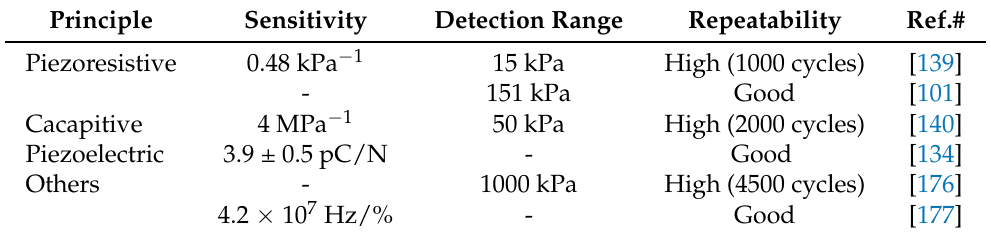
Table 2. Performances of the most relevant works presented in this review